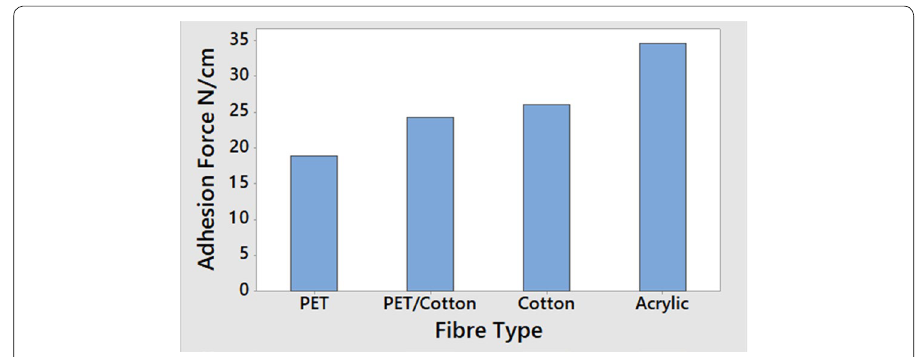
Fig. 11 Effect of fibre type on adhesion